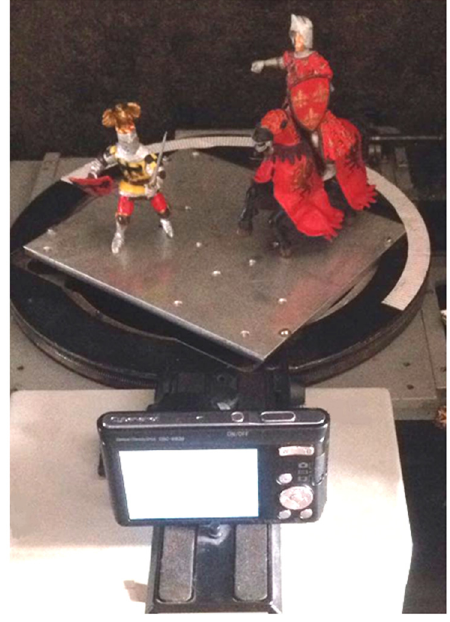
Figure 2. Two-dimensional image capturing by a camera.